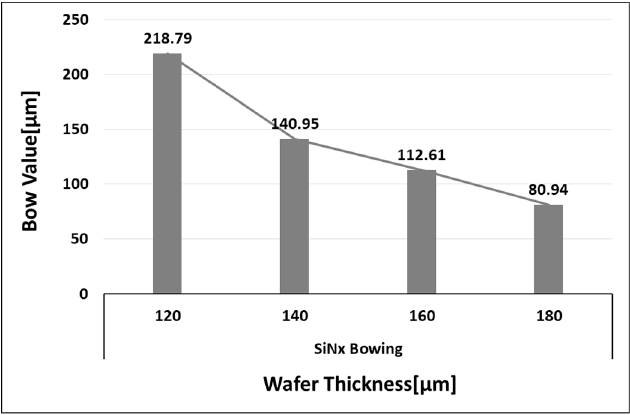
Figure 11. Influence of ARC on bowing phenomenon according to the thickness of c-Si wafers.